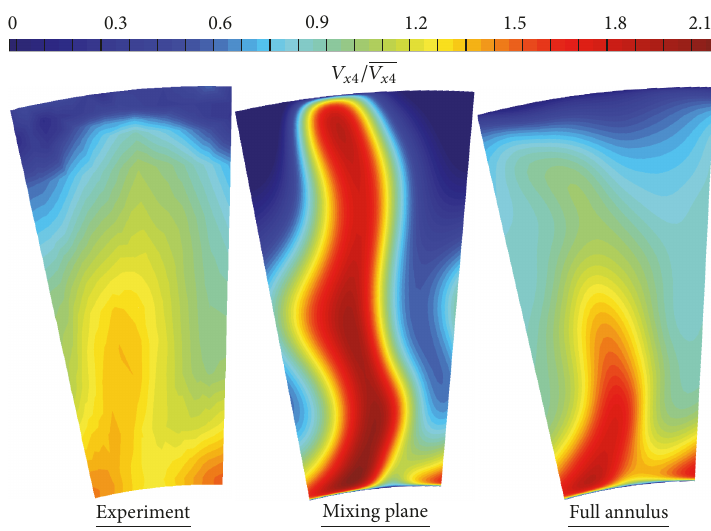
Figure 7: Experimental and numerical reduced axial velocity at stator outlet.